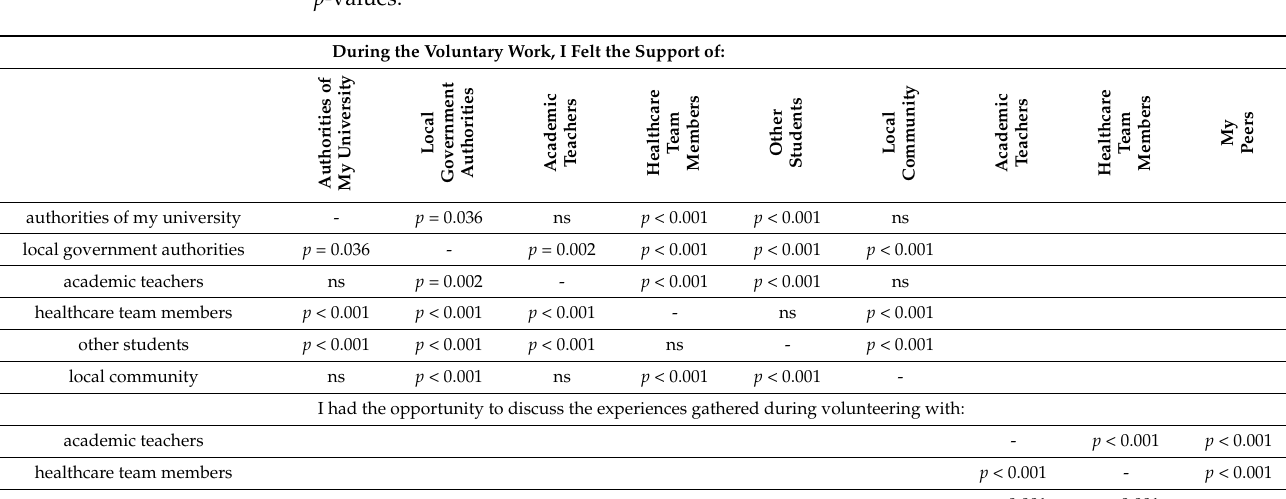
Table 4. Support and reflection opportunities during the volunteering—statistical analysis and p